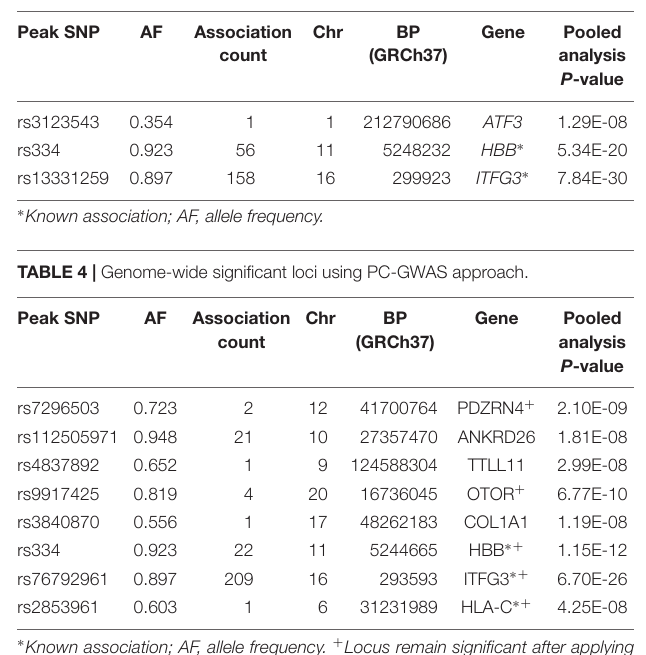
TABLE 3 | Description of genome-wide significant loci using MV-GWAS.